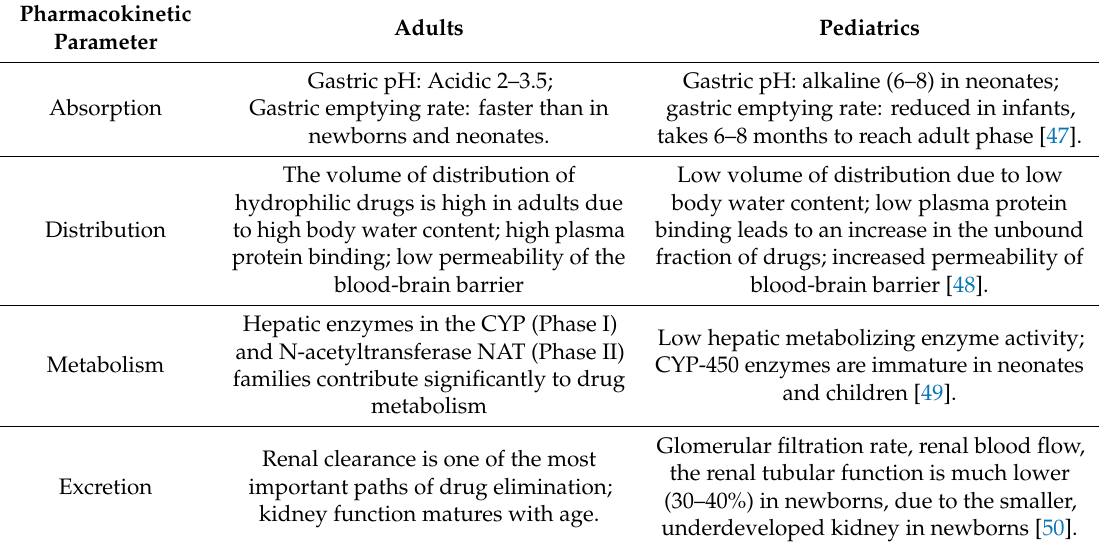
Table 1. Comparison of pharmacokinetic parameters observed in adults and